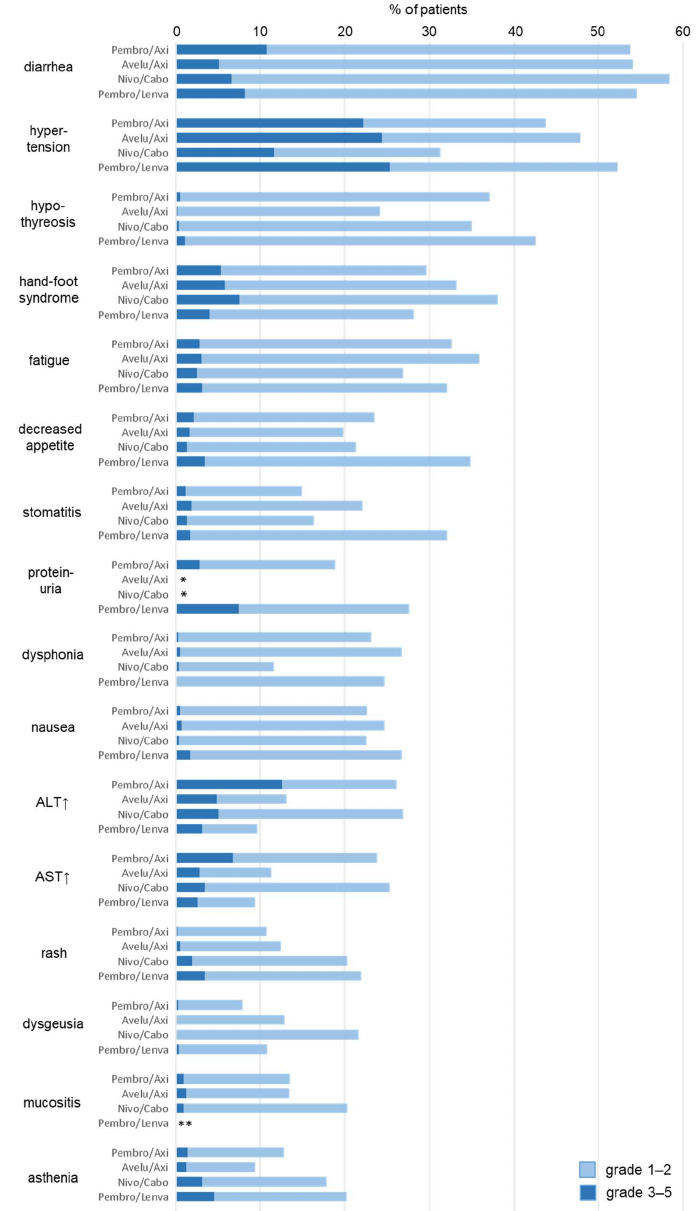
Figure 2. Frequencies of treatment-associated adverse events (trAE) of ICI/VEGFR-TKI combina- tions in metastatic renal cell carcinoma in ≥20% of patients according to KEYNOTE 426 (pembroli- zumab+axitinib, median follow-up: 30.6 months) [12], JAVELIN renal 101 (avelumab+axitinib, me- dian follow-up: 11.6 months) [11], CheckMate 9ER (nivolumab+cabozantinib, median follow-up: 23.5 months) [13], and CLEAR (pembrolizumab + lenvatinib, median follow-up: 26.6 months) [8]. * Not stated, <10% based on trAE of all CTCAE grades; ** <20% based on trAE of all CTCAE grades.